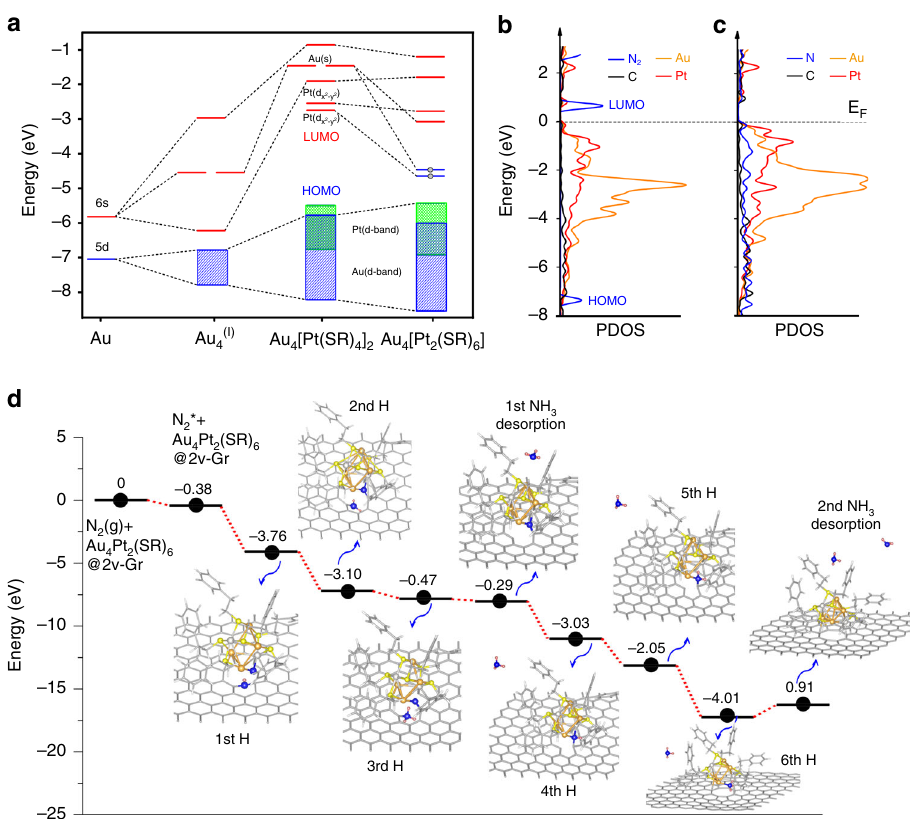
Fig. 5 Probing the catalytic origin of Au 4 Pt 2 /G SCC. a Schematic energy-level diagram of unsupported Au 4 Pt 2 (SR) 8 and Au 4 Pt 2 (SR) 6 clusters. Blue and red lines represent fi lled and empty orbitals respectively. Blue and green blocks represent the d band of Au and Pt, respectively. The two low-lying electrons are shown as dots. b , c Calculated PDOS of Au 4 Pt 2 /G catalysts without and with N 2 adsorption. d Calculated energy pro fi le of the proposed reaction pathway I in which the protonation of N atom bonded with graphene occurs fi rst. Note that NH 3 form when the 3rd and 6th H